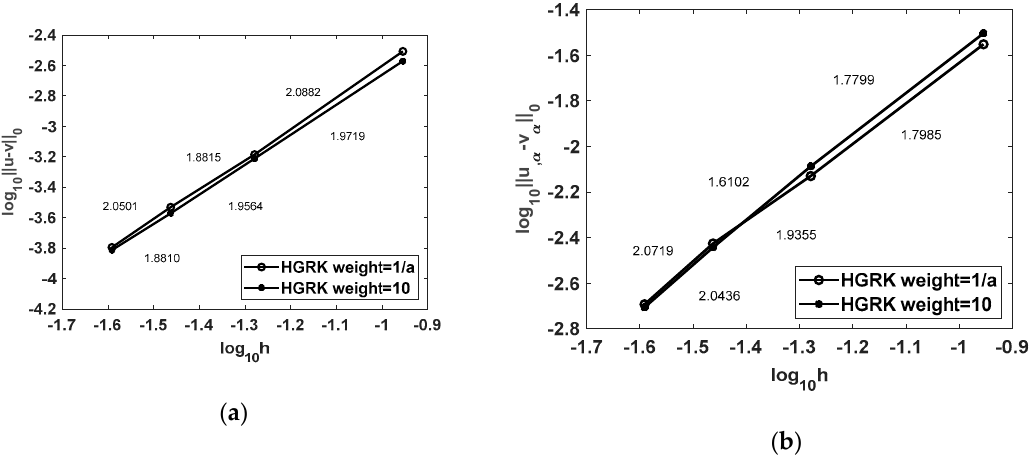
Figure 2. Convergence rates of inverse Helmholtz problem: ( a ) L 2 norm of u ; ( b ) L 2 norm of u, α .